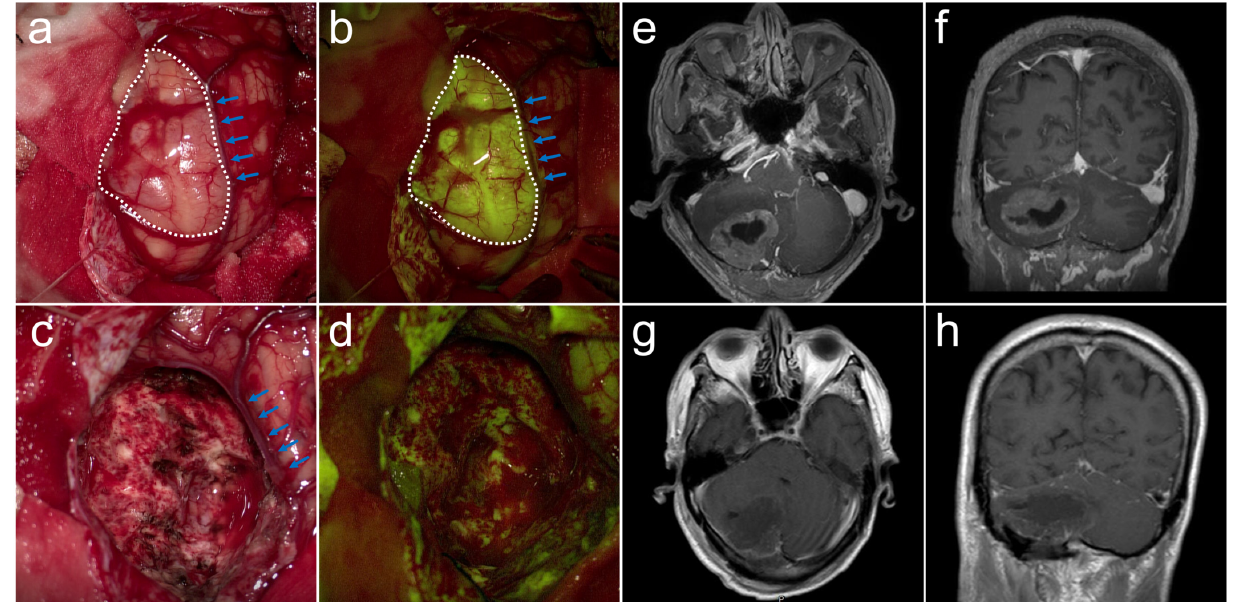
Figure 1. A patient in their 50s underwent SF-guided surgery for adenocarcinoma of the right cerebellar hemisphere. Microsurgical photographs showed the tumor (white dashed frame) located in the cerebellar hemispherical cortex and the draining vein (blue arrowheads) in ( a ) white light mode and ( b ) yellow light mode. The residual cavity after tumor resection in ( c ) white light mode and ( d ) yellow light mode and preservation of the draining vein. ( e – h ) Postoperative axial and coronal magnetic resonance imaging within 72 h showed complete removal of the